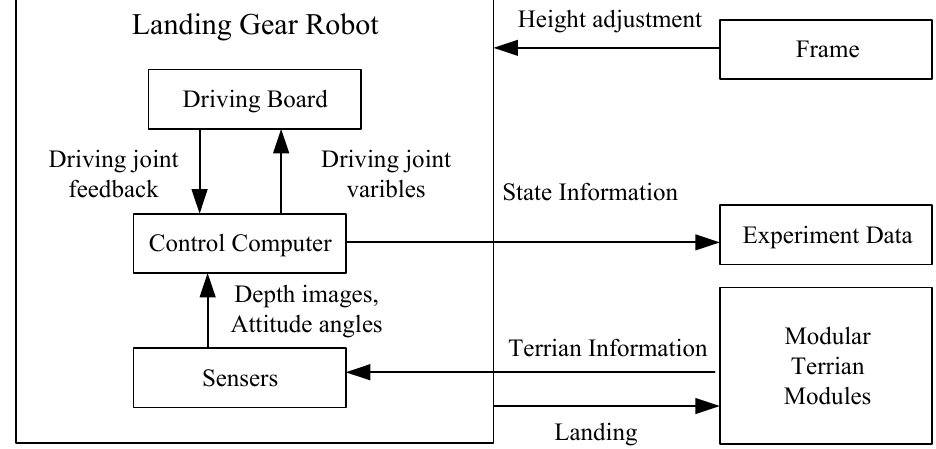
Figure 9. Experiment platform.